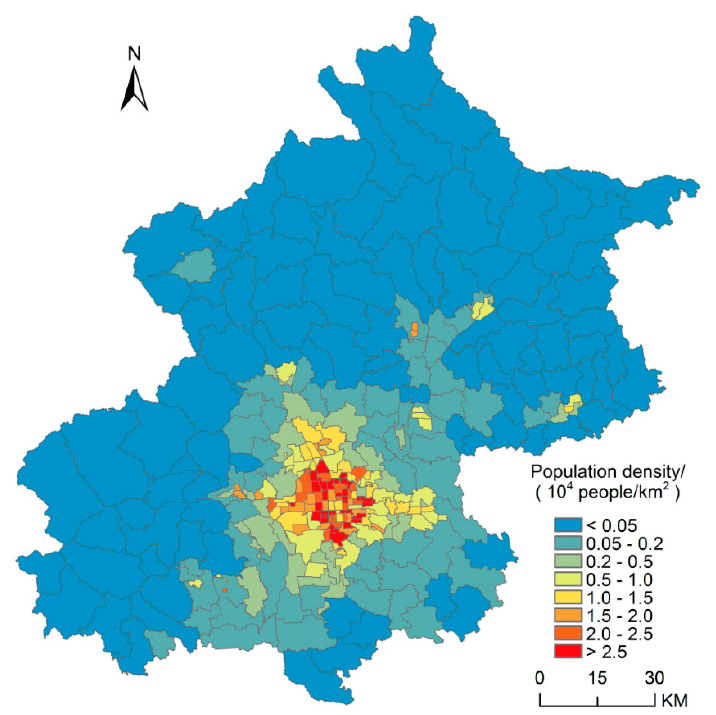
Figure 11. Population density map of Beijing derived from census data.